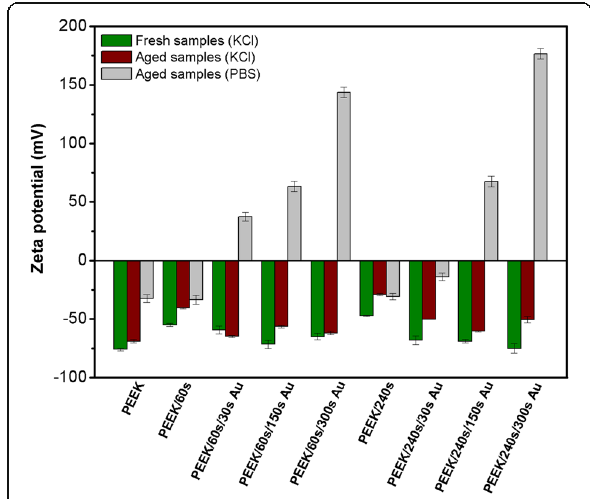
Fig. 2 Zeta potential of plasma-treated PEEK (60 and 240 s) and Au-sputtered (30, 150, and 300 s; current 40 mA) PEEK samples in 1 mM KCl solution ( green columns — fresh samples; brown columns — aged samples) and in PBS solution ( gray columns )